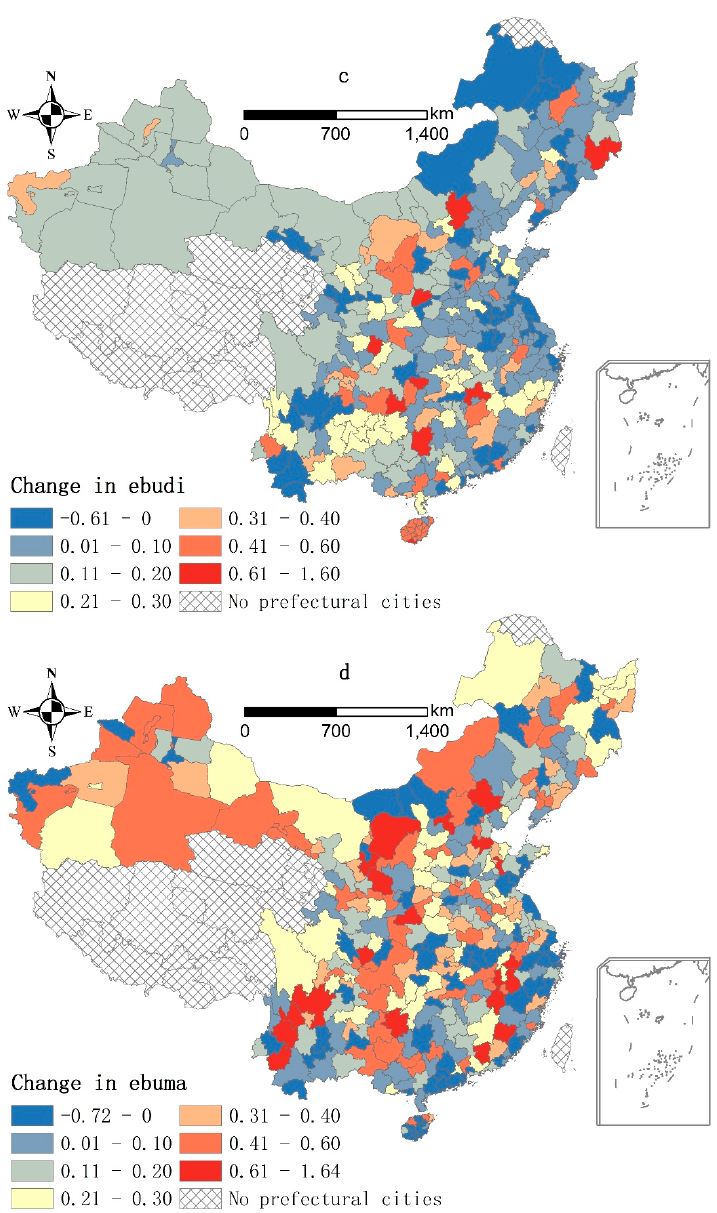
Figure 4. Change in environmental benefits of urban land use in the prefectural cities, China,